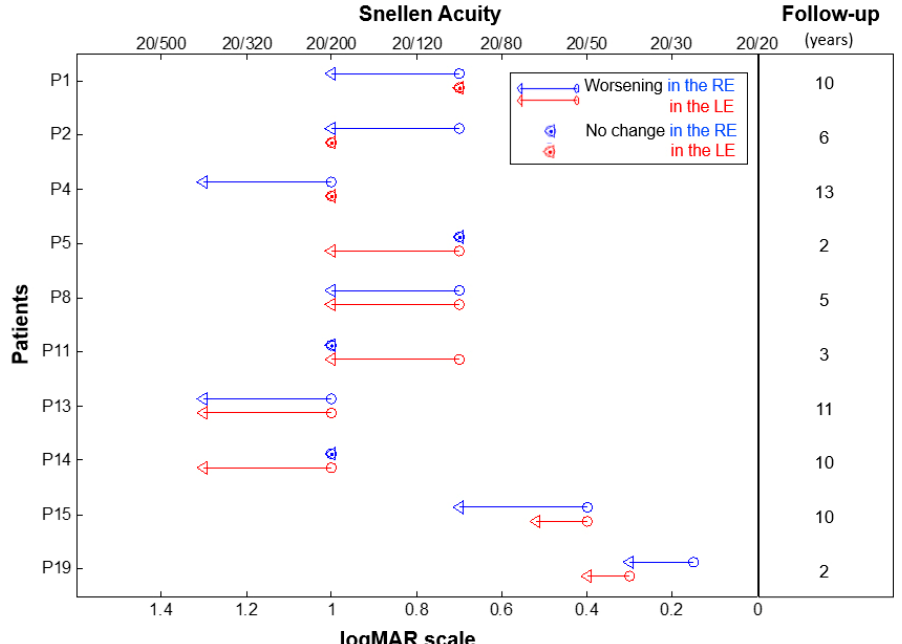
Figure 1. Change in the best corrected visual acuity in individual ACHM patients showing a worsening over the follow-up period. Baseline and last time-point visual acuities are represented by circles and triangles, respectively. Data from the right eye (RE) are in red and left eye (LE) in blue. The duration of the follow-up period (in years) for each patient is shown on the right. Patient ID is shown on the left.